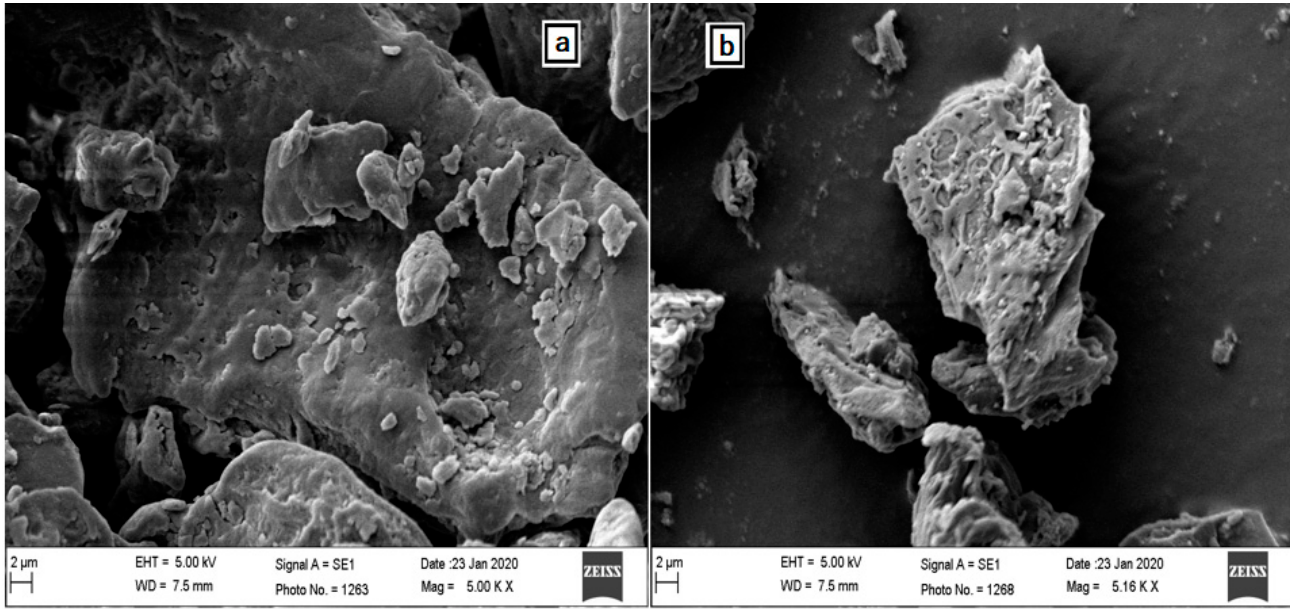
Figure 3. A scanning electron microscopic image of ( a ) raw CH ( b ) and treated CH.